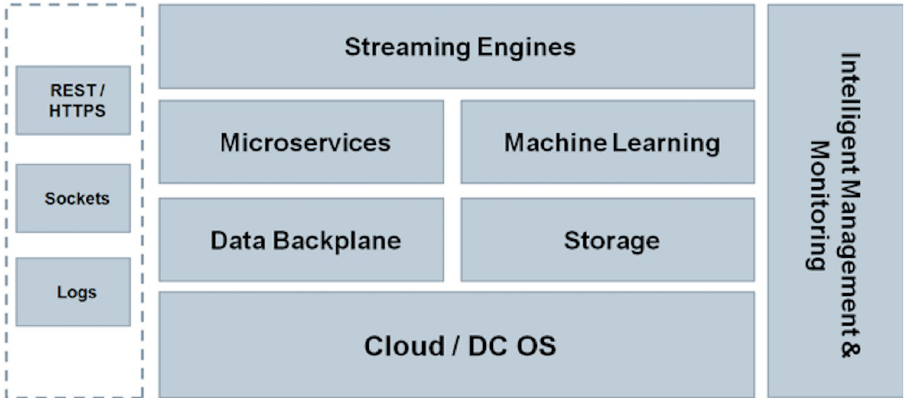
Fig 5. Overall concept and specific components for developing the cloud based